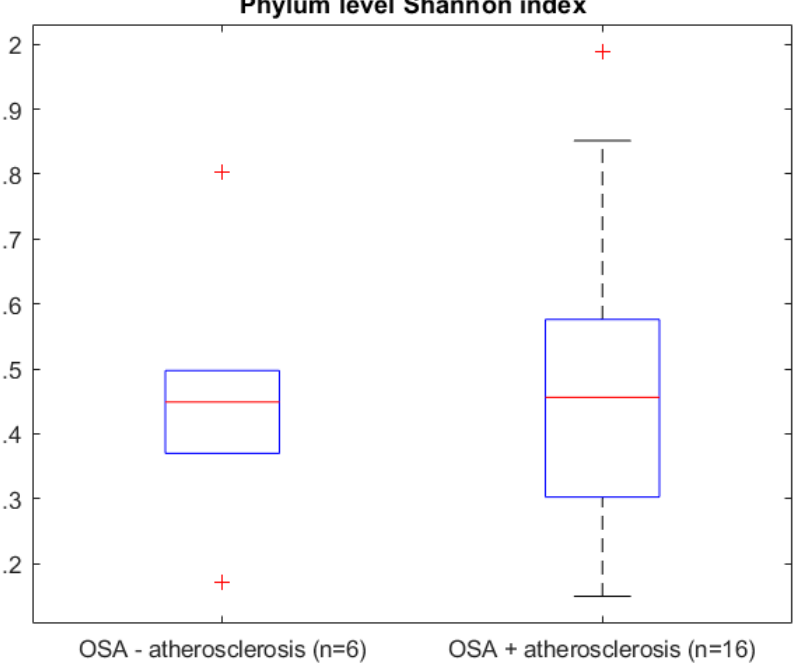
Figure 1. Discriminant features between the two groups based on the LEfSe method. Red bars represent taxa more abundant in the atherosclerotic group, green bars represent taxa more abundant in the non-atherosclerotic group.